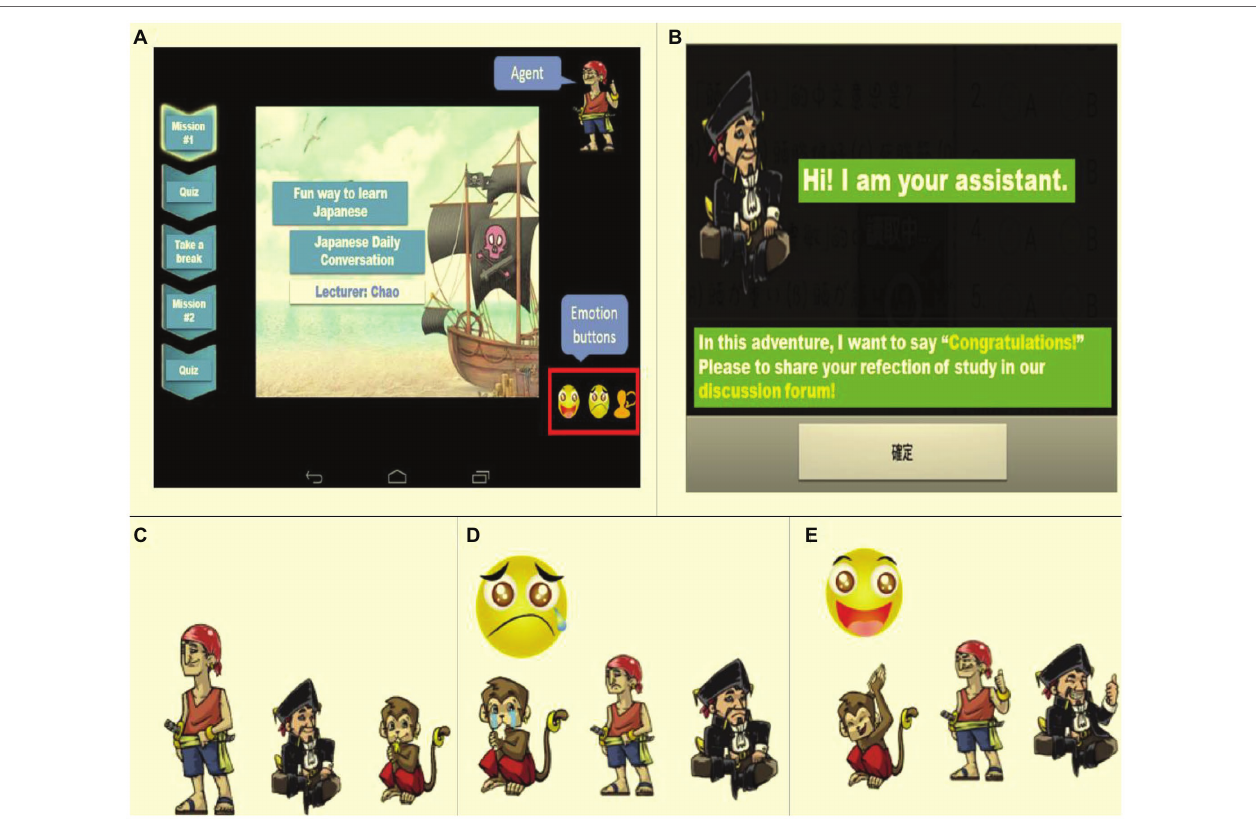
FIGURE 2 | (A) Positive/negative emoticons on the course interface and emotion-related words for sentence formation. (B) Feedback at the end of the course. (C) Agent (from left to right): Sailor, shipmaster, monkey. (D) The agent’s response when a negative emoticon is selected. (E) The agent’s response when a positive emoticon is